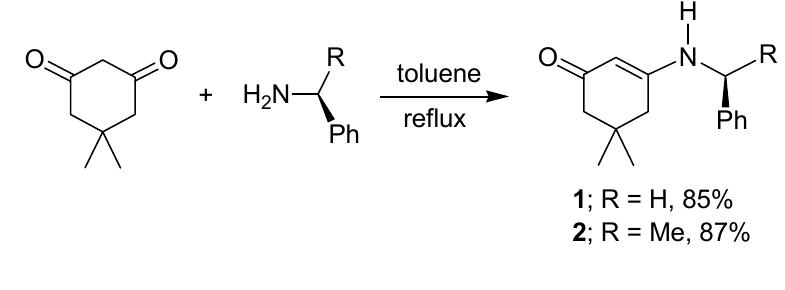
Figure 1. X-Ray structure of β -enaminoketone 2